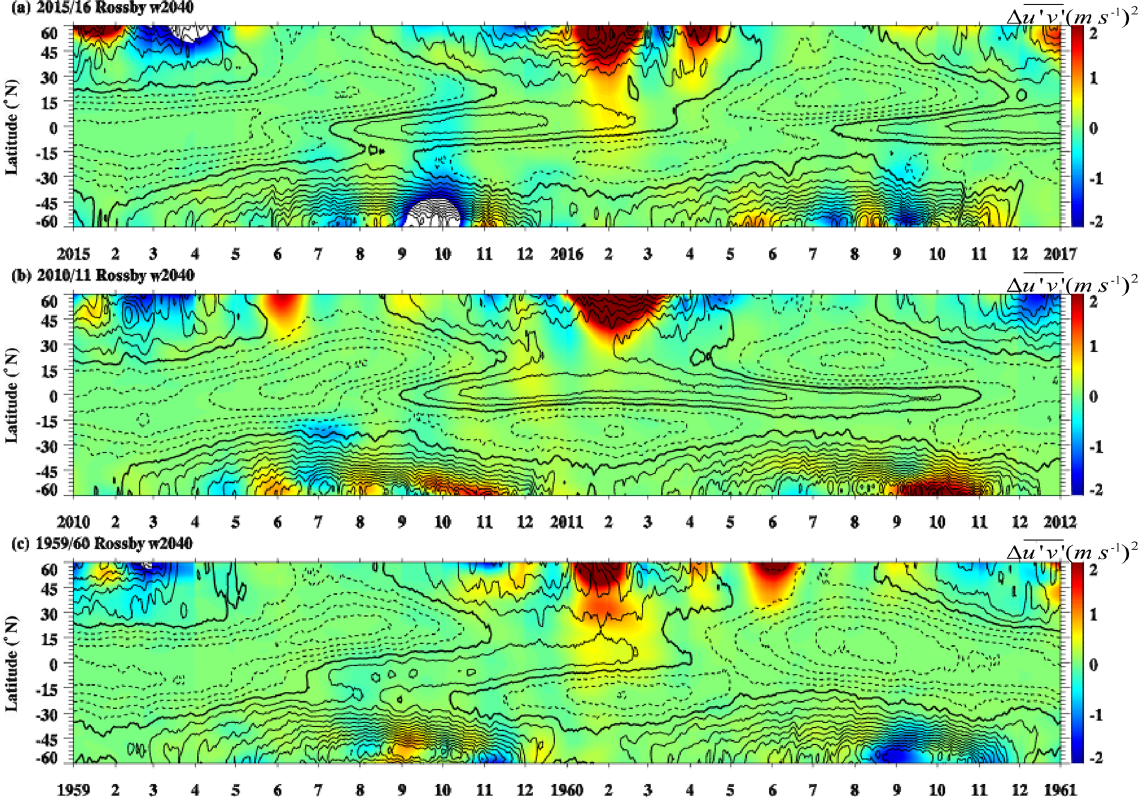
Figure 6. The time–latitude cross section of Rossby waves (with periods of 20–40d and with wavenumber 1) horizontal momentum flux anomaly in (a) 2015/2016, (b) 2010/2011, and (c) 1959/1960 at 40hPa. Color shadings denote the anomalies with respect to the monthly climatology (0m 2 s − 2 ). The zonal mean zonal wind is overlaid in black contours with contour interval of 5ms − 1 . The solid and dotted black contours denote westerly and easterly winds, respectively. The thick contours represent the zero wind